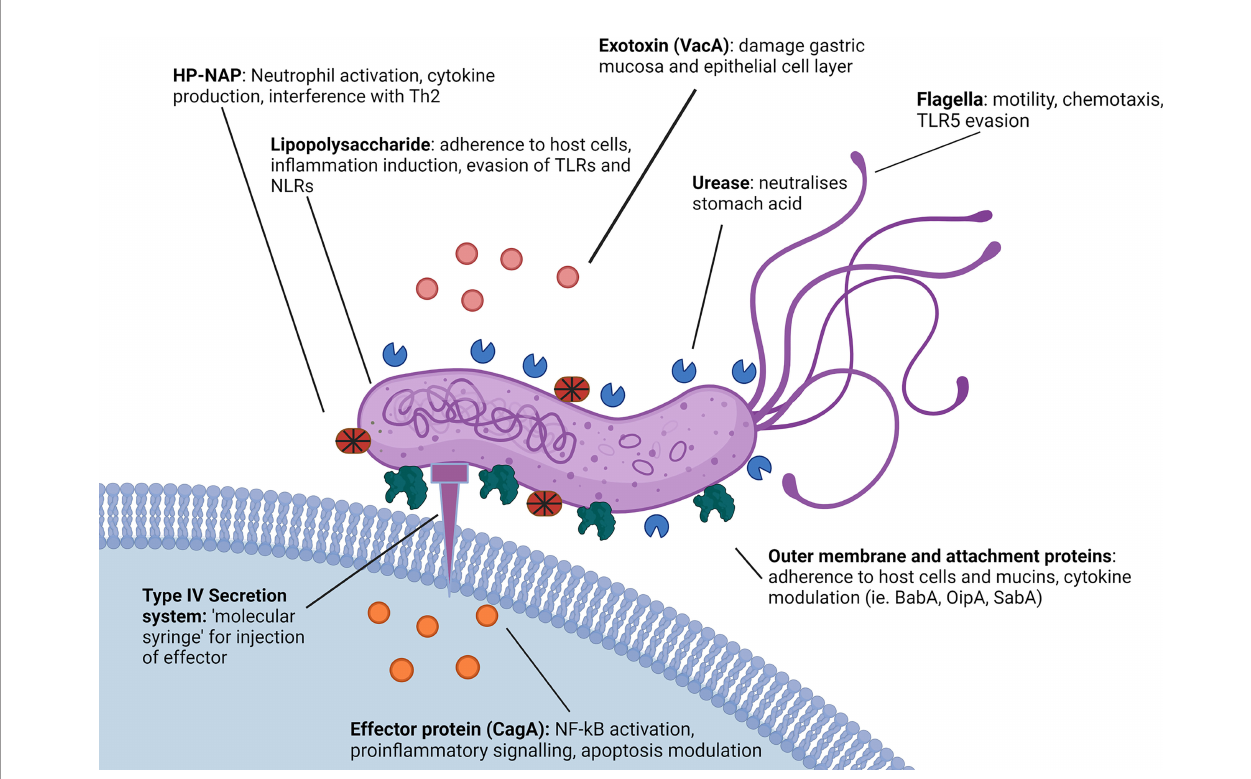
FIGURE 2 | Role of H. pylori virulence factors in innate immune evasion. H. pylori utilises a number of virulence factors to enable immune evasion. H. pylori possesses a less immunogenic LPS in comparison to other gram-negative microbes and both the LPS and several H. pylori virulence proteins such as SabA and OipA demonstrate variable expression patterns affecting the immune response (68, 69). Additionally, H. pylori expresses proteins such as HP-NAP, VacA and CagA that actively modulate cytokine and in fl ammatory signaling, as well as DC and macrophage function (56, 70). H. pylori fl agella protein FlaA also evades detection by TLR5 via a series of complex point mutations (65). Created with